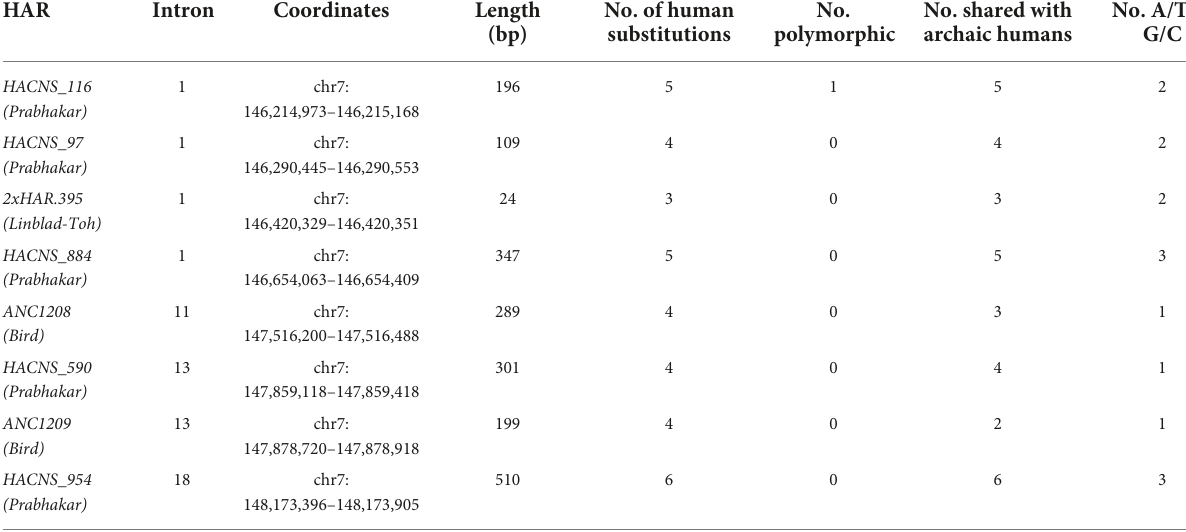
TABLE 2 Contactin-associated protein-like 2 ( CNTNAP2 ) human accelerated regions (HARs). HAR Intron Coordinates Length